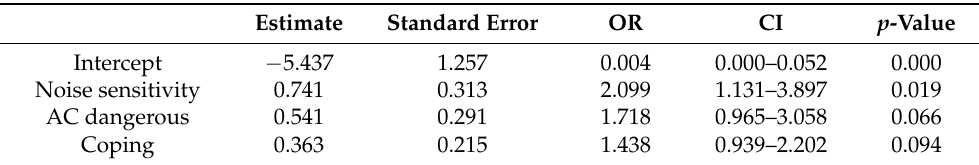
Table 3. Multiple logistic regression model LR1 with random effects for the prediction of aircraft noise-induced short-term annoyance at night in children. Adjusted Odds Ratios (OR) with 95% Confidence Intervals (CI) and p -values, AIC =